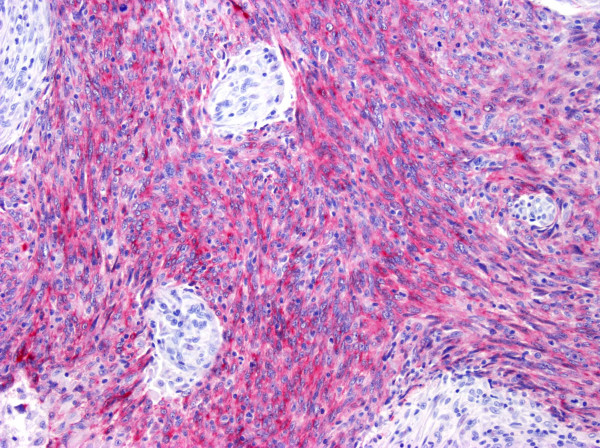
Detection of LMP-1 expression by immunohistochemistry (red) in UNPC tumor cells. Alkaline phosphatase anti-alkaline phosphatase, original magnification ×250.